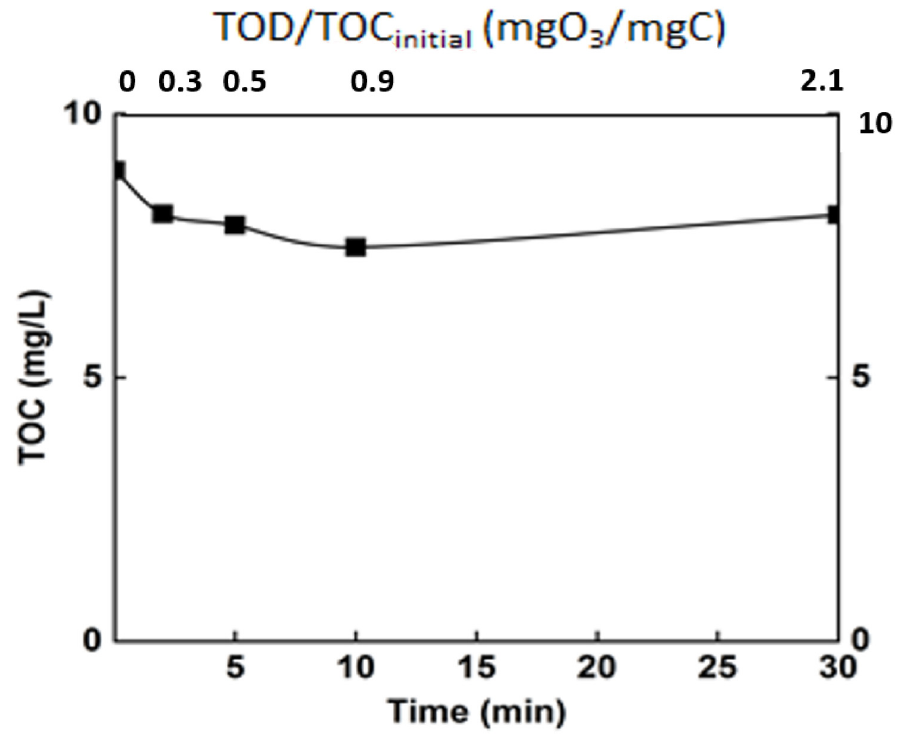
Figure 7. Monitoring of the mineralization rate of the real matrix during ozonation. T ◦ = 20 ◦ C, Vreactor = 3 L, Vstir = 400 rpm, [O 3 ]gas = 5 gO 3 /Nm